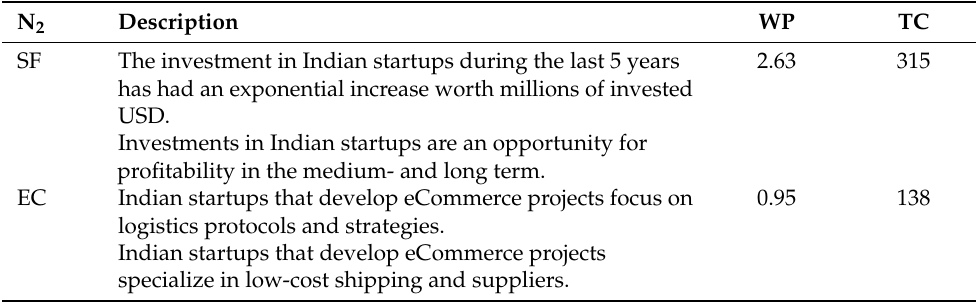
Table 5. Results for N 2 for startups neutral key indicators for investors.